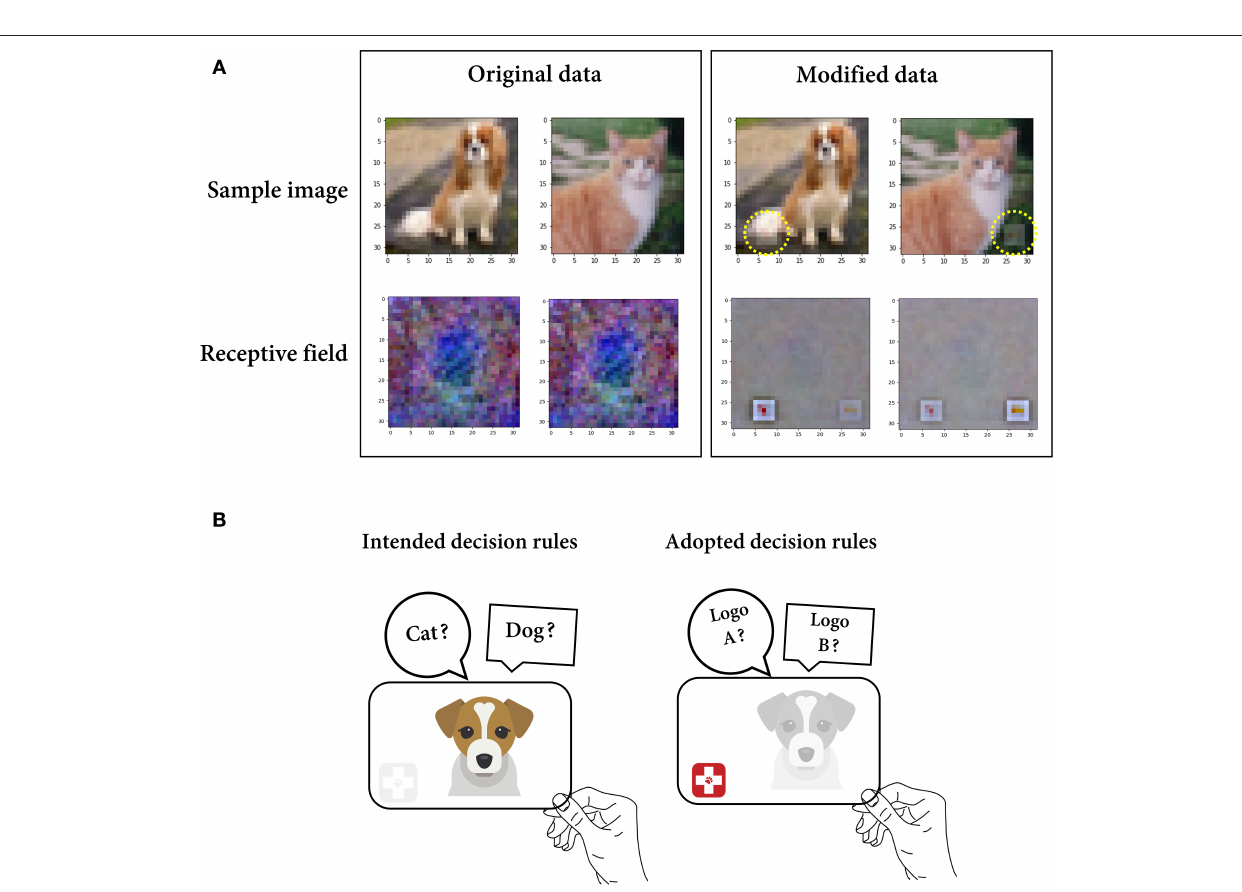
FIGURE 3 | Irrelevant feature selectivity. (A) Instance images (top) of a dog and cat in the original/modified (logo-synthesized) dataset and reconstructed receptive field (bottom) for the dog and cat classes from the model trained on either the original or modified dataset. (B) A schematic figure illustrating the situation where the solution learned by the model (right) is different from the researcher’s intended solution (left).